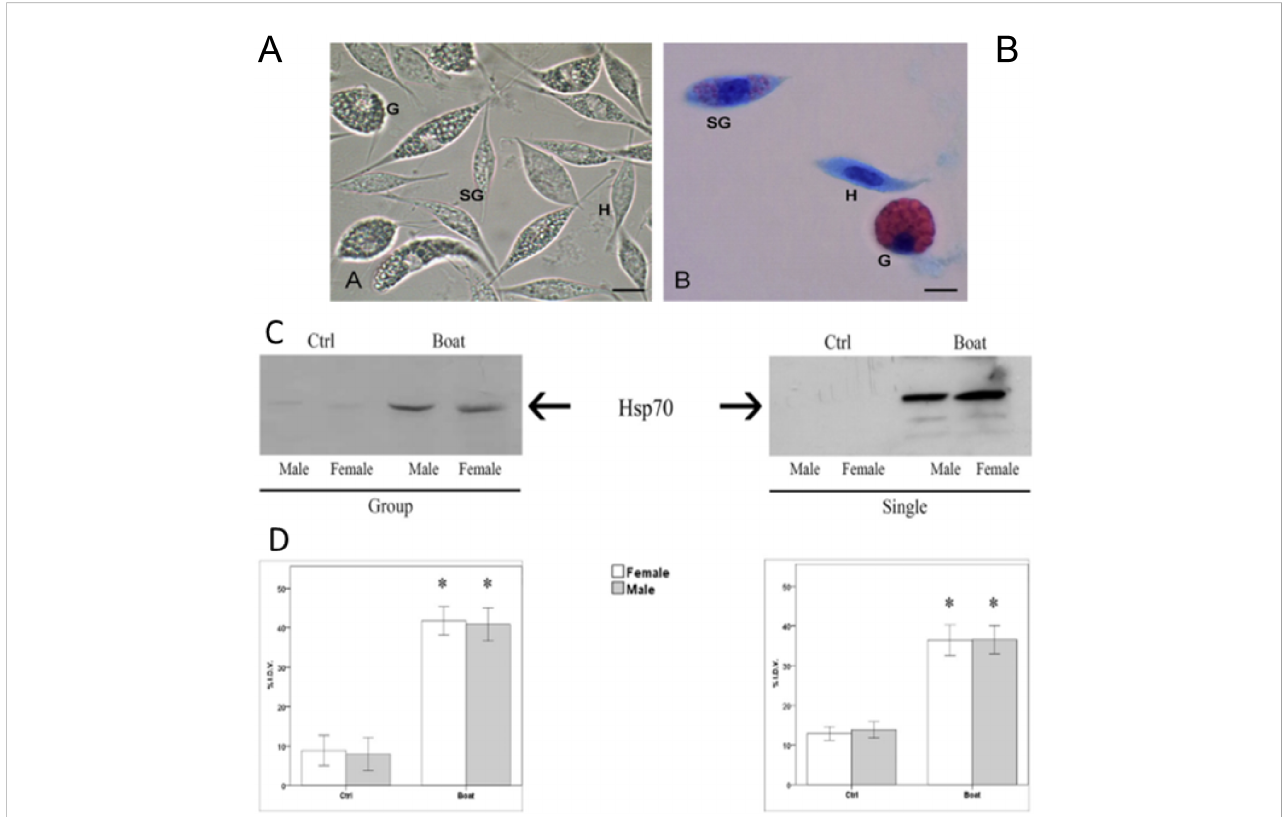
FIGURE 3 Light Microscopy. Haemocytes of the spiny lobster Palinurus elephas (A) no staining and (B) stained with May – Grünwald – Giemsa. H: hyalinocytes; SG: semigranulocytes; G: granulocytes. Scale bars: (A, B) = 8 µm. Effect of the acoustic stimuli on the expression levels of the protein Hsp70 in P. elephas ; (C) Representative western blot of Hsp70 levels in single and grouped animals. (D) Integrated density value (% IDV) of the Hsp70 protein bands. Data are the means ± standard error (N = 18 control and N = 18 test specimens). Asterisks represent signi fi cant differences between CTRL and BOAT condition (*= p < 0.01). (Filiciotto et al.,